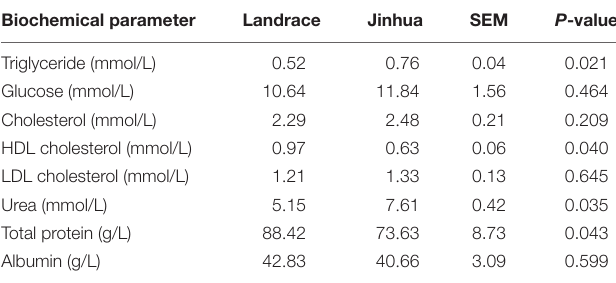
TABLE 1 | Biochemical parameters in the sera of Landrace and Jinhua pigs. Biochemical parameter